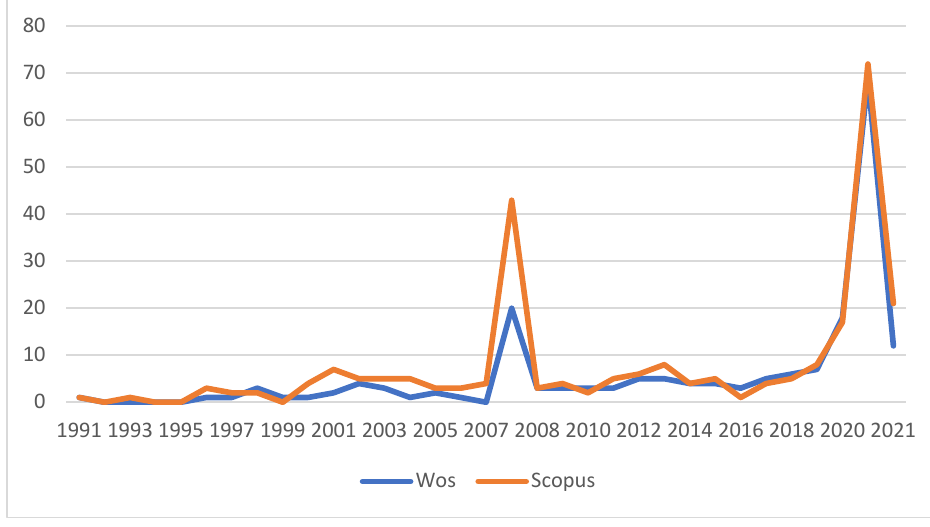
Figure 2. Number of articles per year.